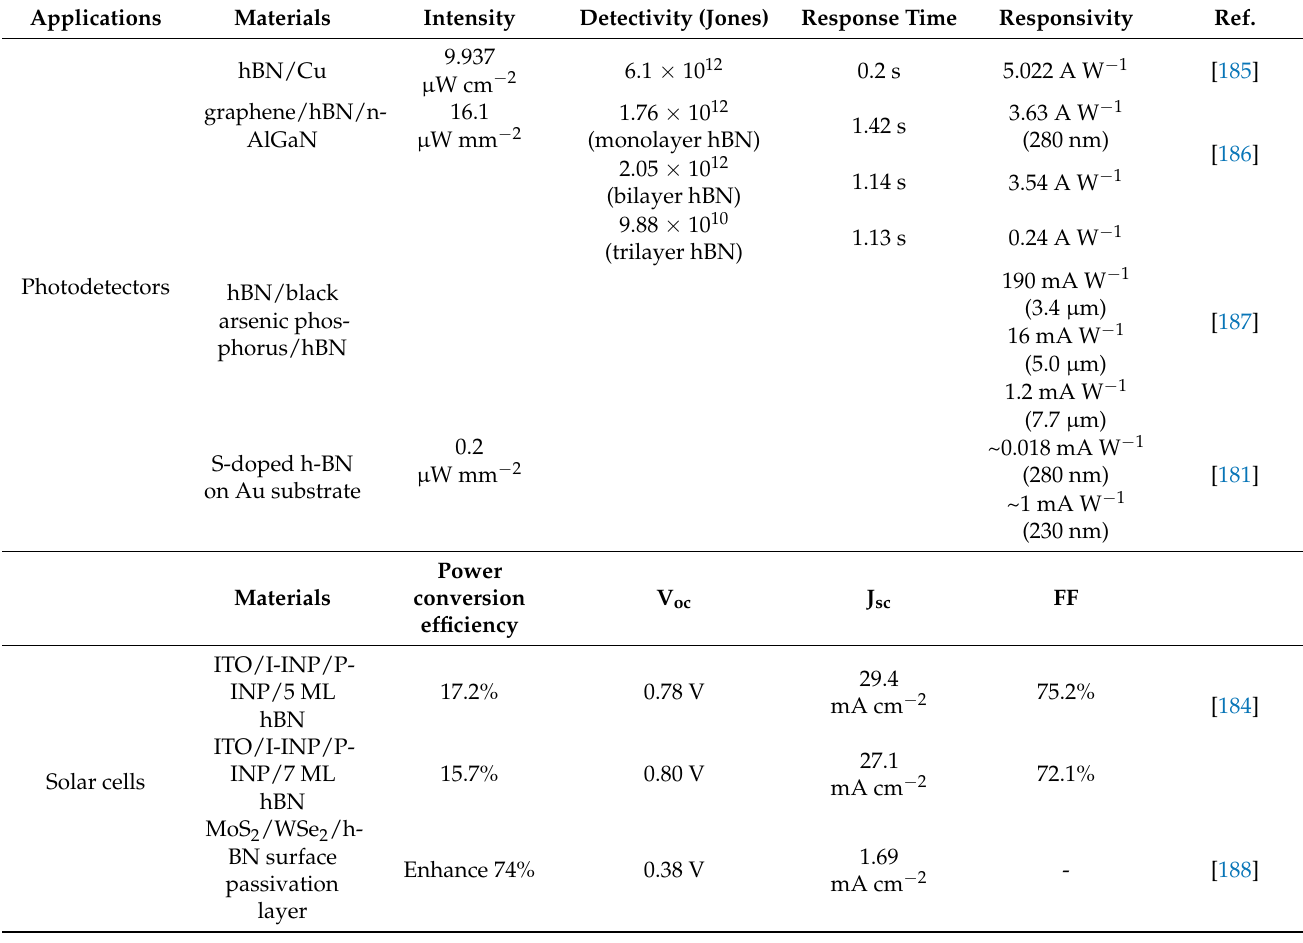
Table 3. Optoelectronic devices based on